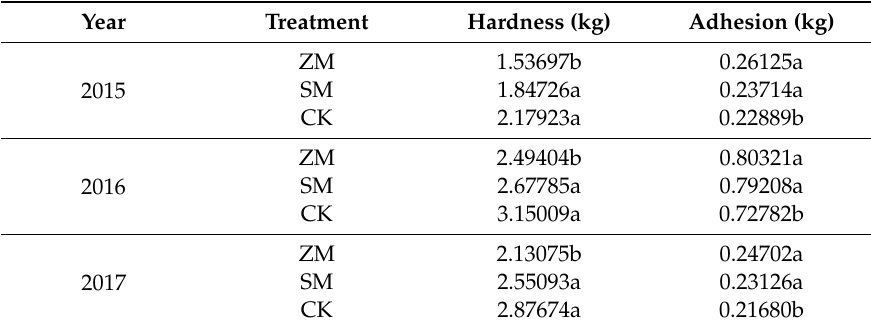
Table 1. E ff ect of di ff erent films mulching on rice